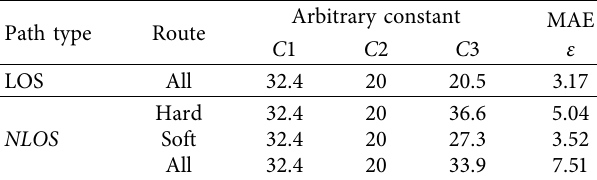
Table 2: Summary of the CI arbitrary constants 28GHz.